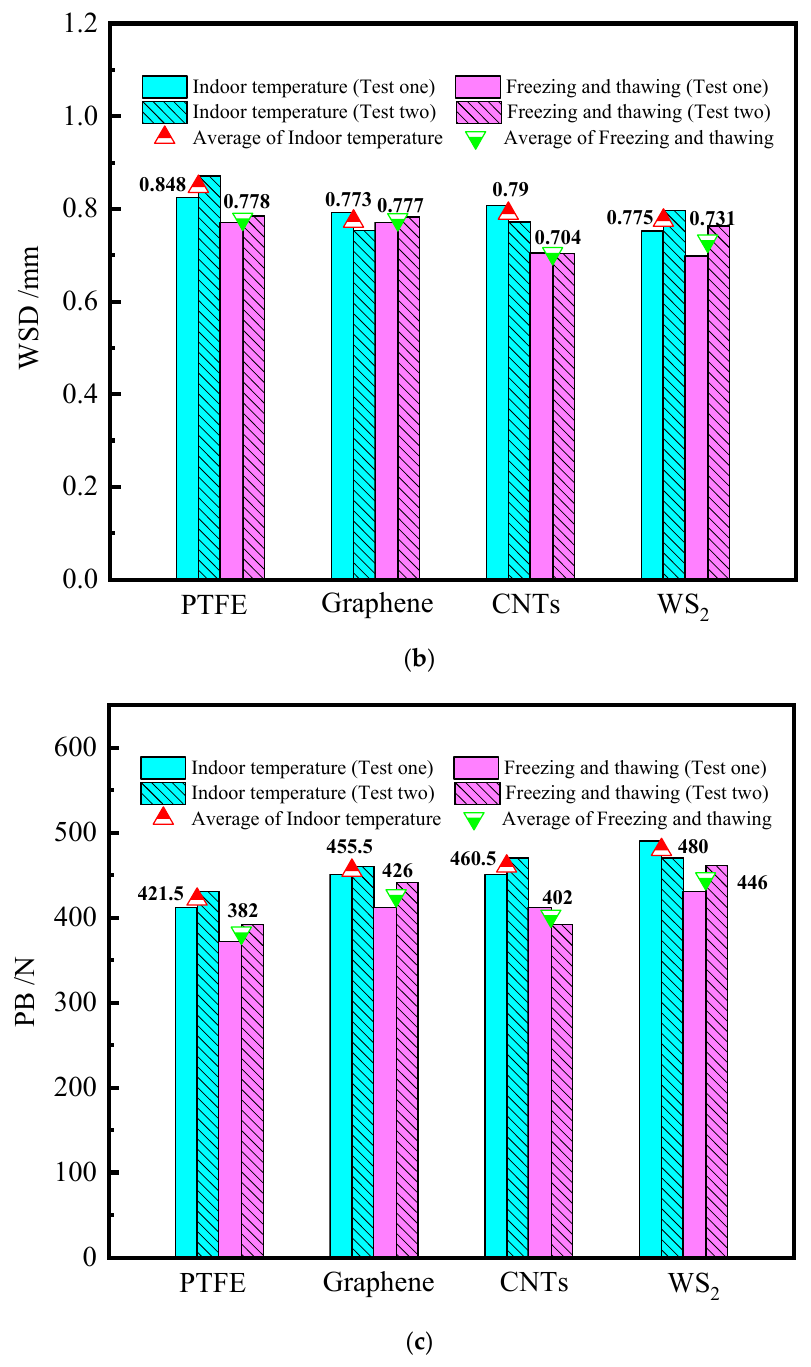
Figure 4. Comparison of tribological properties of admixtures for spherical hinge lubrication: ( a ) COF ( b ) WSD ( c ) PB.